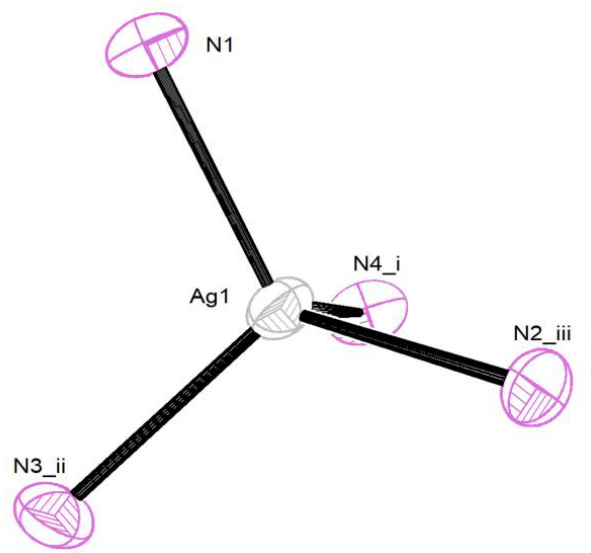
Figure 5. The coordination sphere of Ag1. Symmetry operators: i: ½ – x, ½ – y, 1 – z ; ii: x – ½ , 1.5 – y, z – ½ ; iii: ½ – x, y – ½ , 1.5 – z.